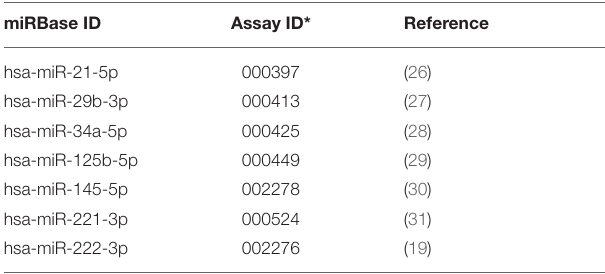
TABLE 1 | MicroRNAs evaluated after fibronectin exposure in prostate cancer